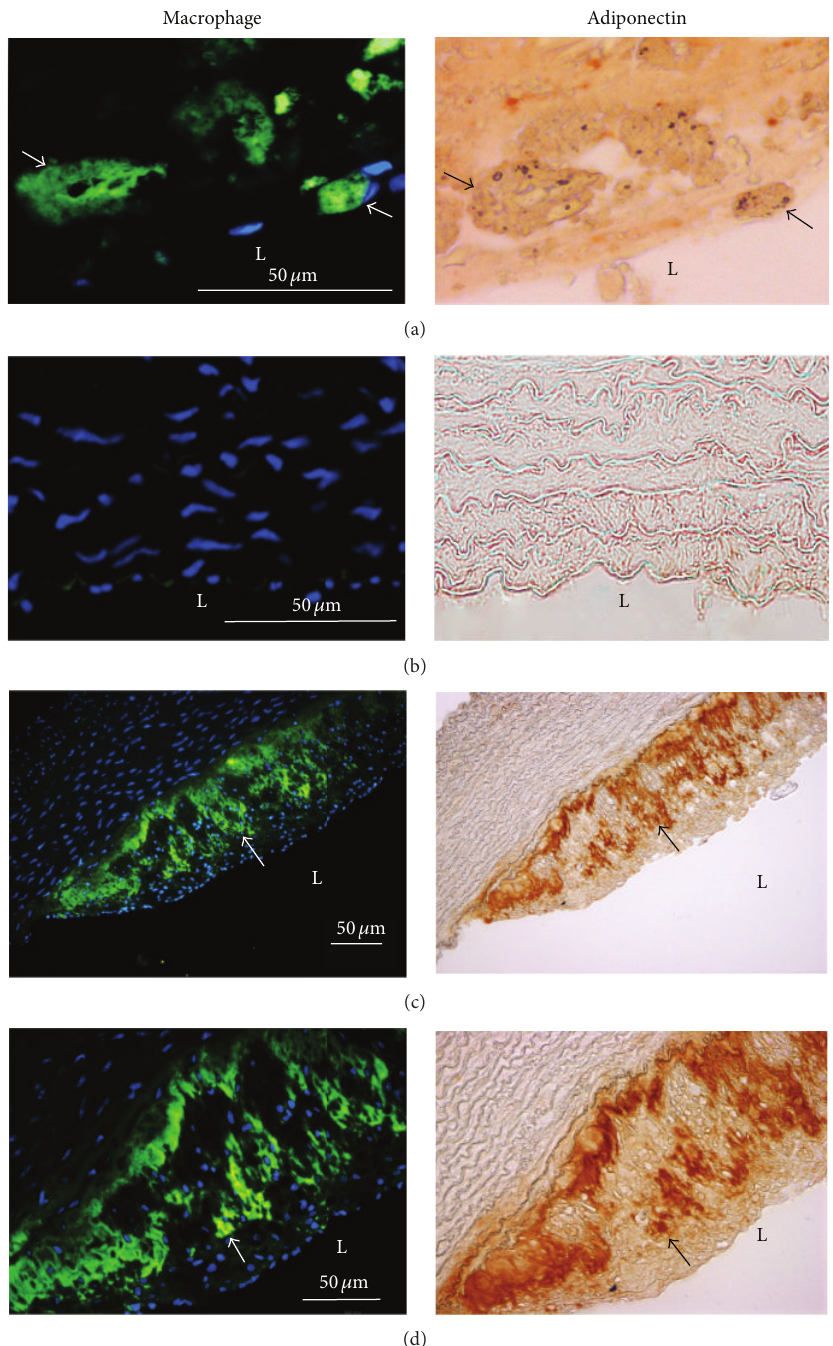
Figure 2: The expression of adiponectin was located in macrophages of atherosclerotic lesions from patients and cholesterol-fed rabbits by immunohistochemistry. Arterial serial sections from human atherosclerotic lesions (a), rabbits fed regular chow (b), or 2% cholesterol- containing diet for 6 weeks ((c), (d)) were stained for macrophages or adiponectin antibodies. Nuclei were stained by DAPI. L represents the vascular lumen. Bar = 50 𝜇